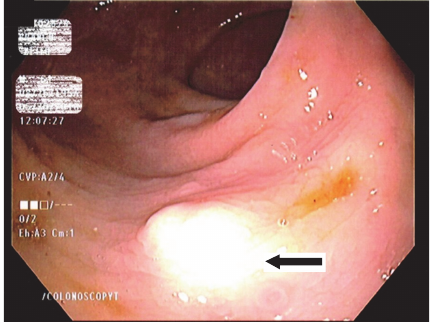
Figure 3: Biopsy revealing positive immunohistochemical staining for S-100